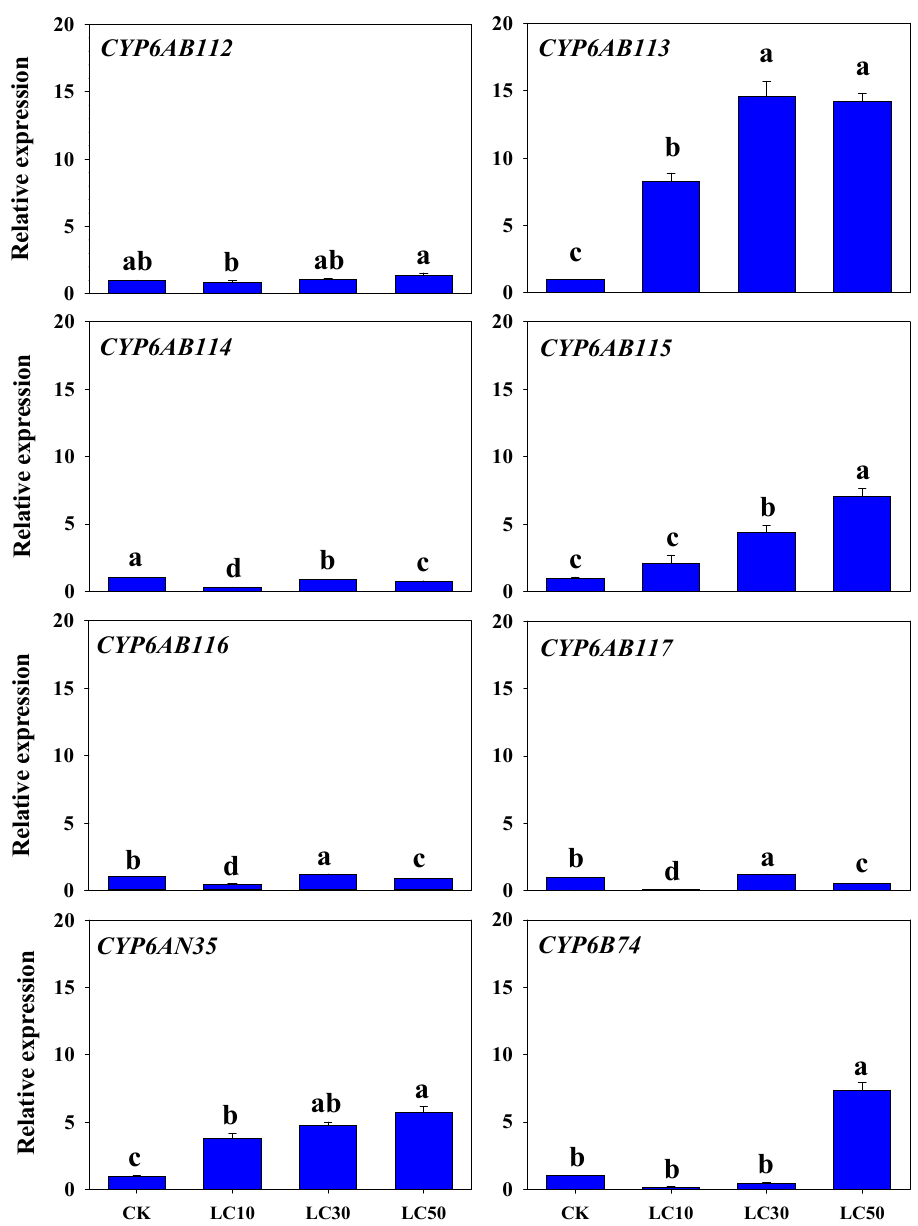
Figure 5. Relative expression of CYP6 genes in G. molesta treated with different concentrations of malathion. Note: control (CK), lethal concentration 10% (LC 10 ), lethal concentration 30% (LC 30 ), and lethal concentration 50% (LC 50 ). Each treatment included three biological replicates. The data in the bar charts are presented as the means ± SEs. Different letters indicate significant differences at the p < 0.05 level, as determined by ANOVA and Tukey’s HSD test.